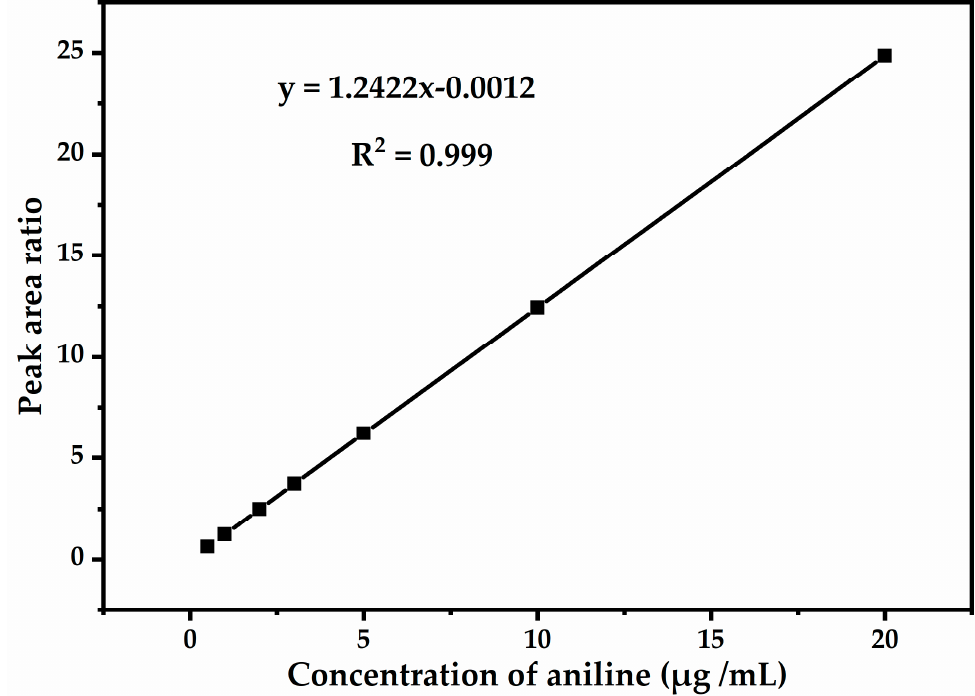
Figure 3. Standard curve and correlation coefficient of aniline (the levels of aniline were 0.5 μ